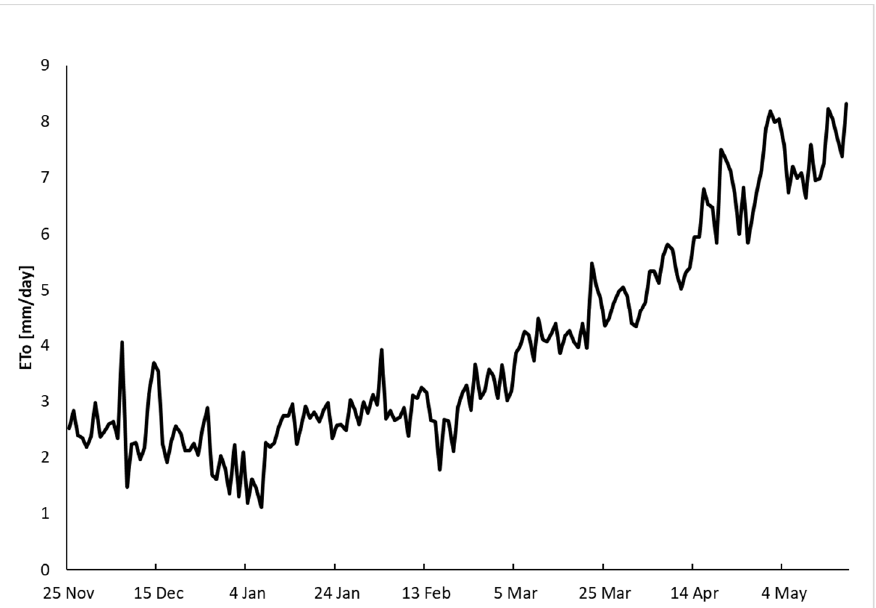
Figure 5. Daily Reference Evapotranspiration (ETo) calculated based on meteorological parameters at Sids Station.